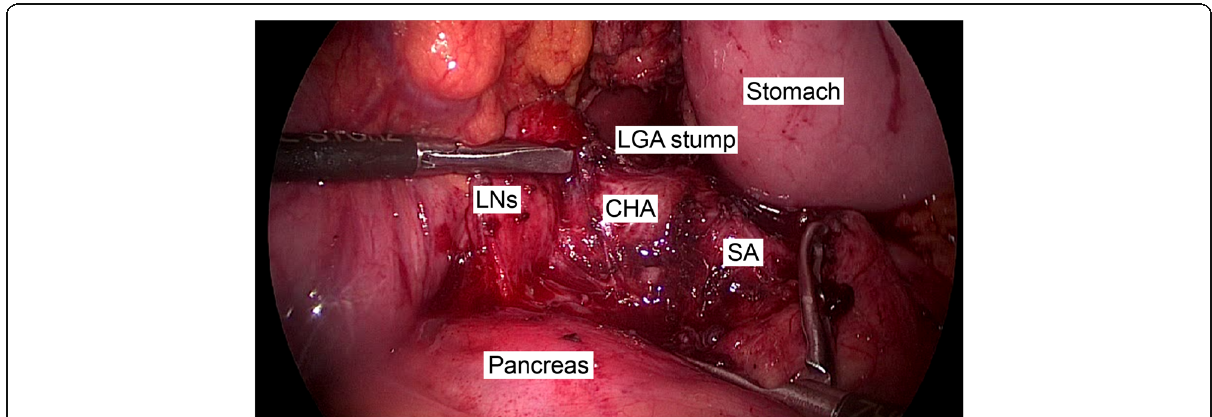
Fig. 3 Dissection of lymph node groups 7, 8a, 9, 11p. CHA: common hepatic artery, SA: splenic artery, LGA: left gastric artery, LNs: lymph